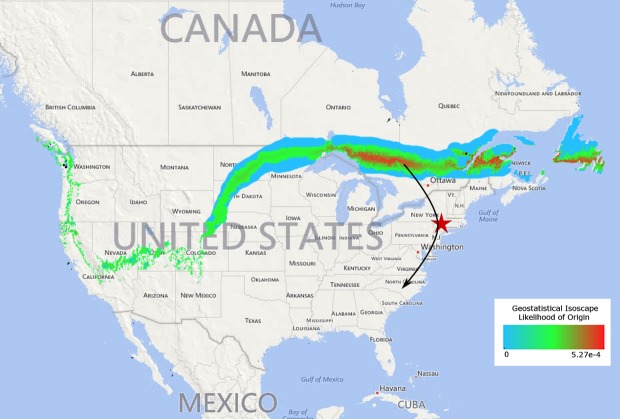
Geostatistical isoscape estimates for the origin of Northern saw-whet owls that were netted and banded in the Hudson Valley of New York. Estimates are based upon δ2Hydrogen analysis of feathers of hatch-year owls. IsoMAP Project: Isoscapes Modeling, Analysis, and Prediction (version 1.0). Available at: http://isomap.org.